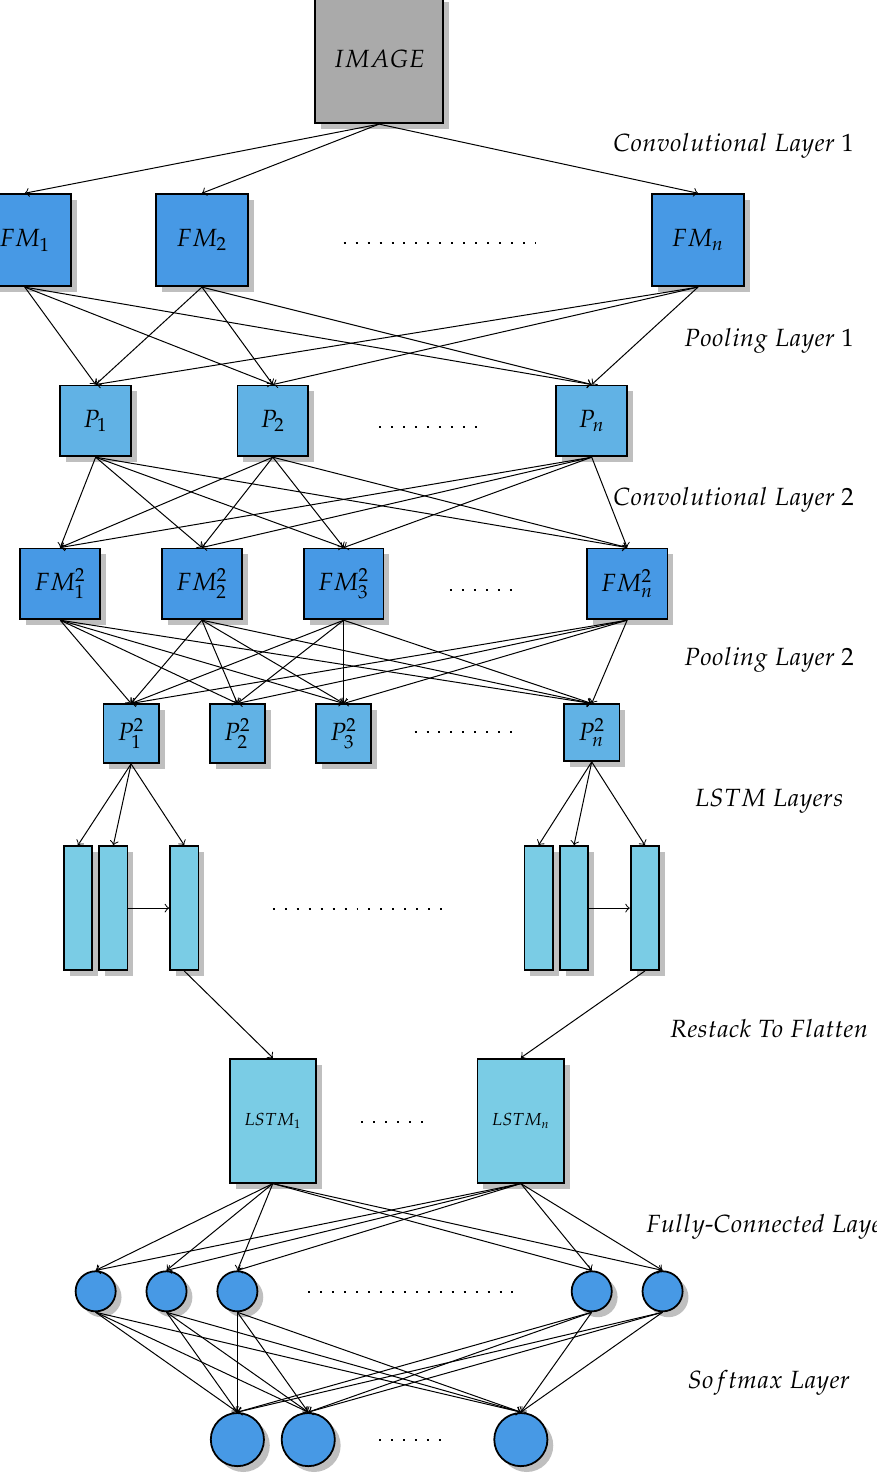
Figure 1. Network infrastructure (where FM i is the i -th feature map and P i is the i -th pooling